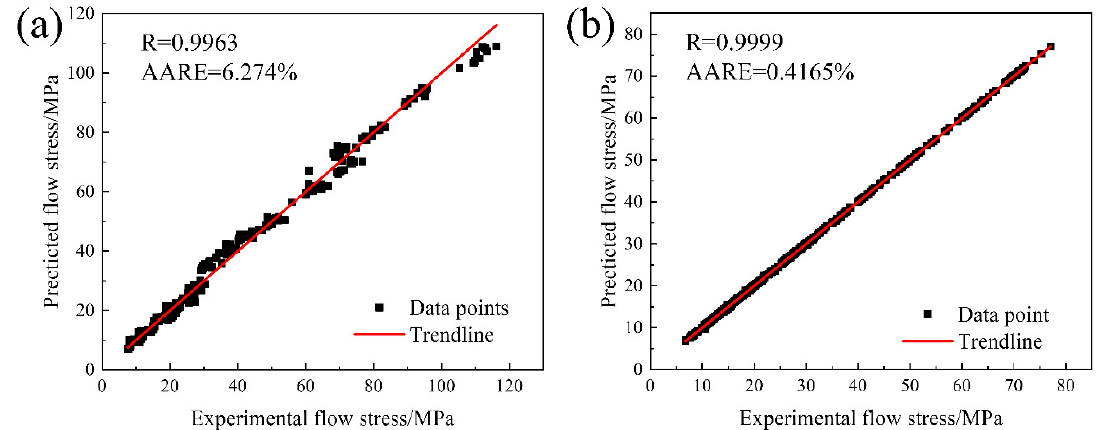
Figure 8. Comparison of predicted and experimental flow stress by ( a ) strain-compensated Arrhenius model and ( b ) BP ANN model.